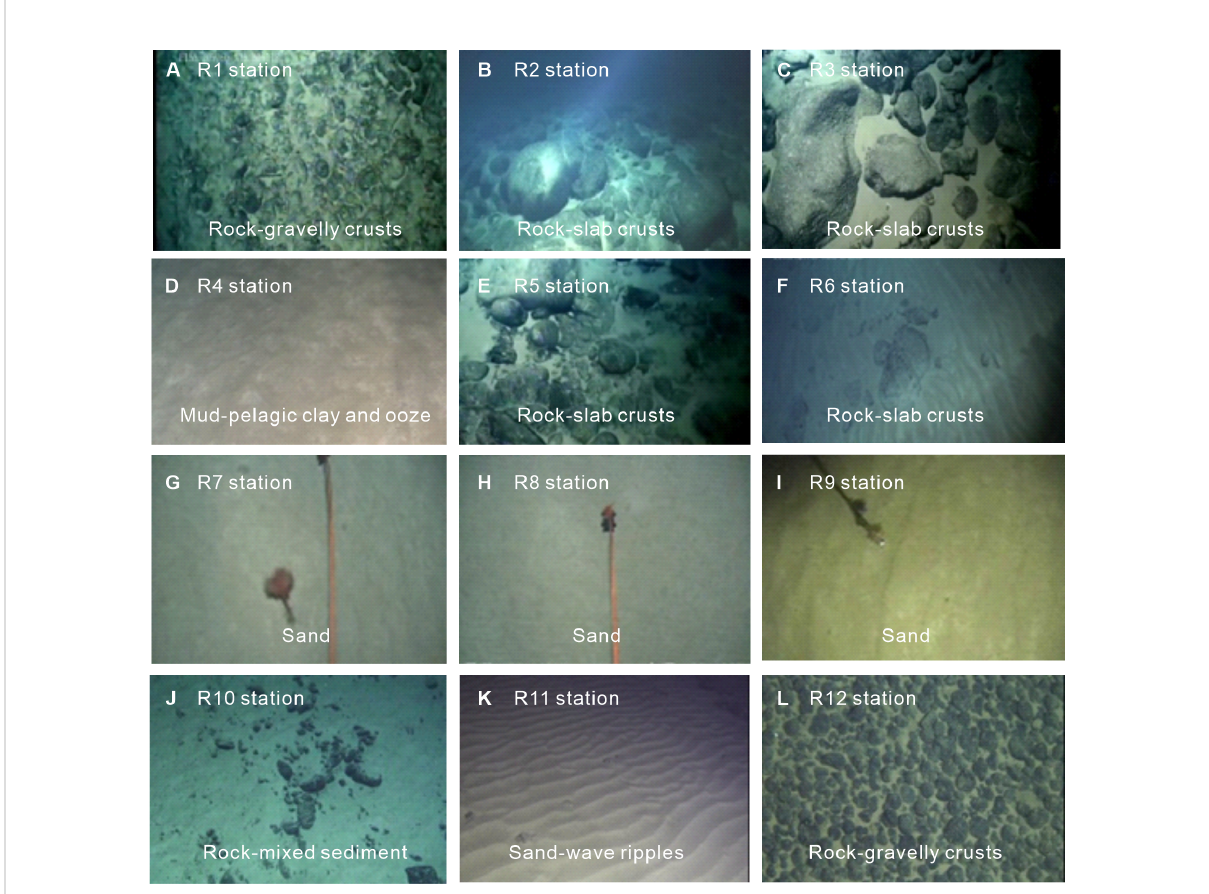
FIGURE 7 Still images of substrate. (A) and (L) show Rock- gravelly crusts appearance on R1 and H12. (B), (C), (E), (F) show Rock- slab crusts appearance on R2, R3, R5, R6. (D) shows the Mud- pelagic clay and ooze on R4. (G – I) show sand substrate on Flat top areas of V2, V5 and V6. (J) shows the Rock- mixed sediment on lower slope area of H9. (K) shows Sand-wave ripples on Flat top area of